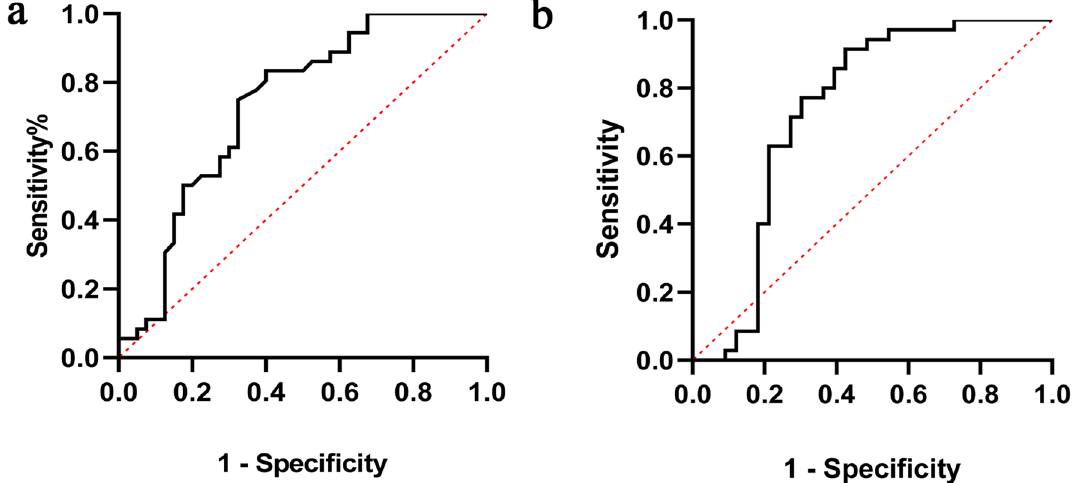
Figure 2. ROC curve analysis for determining statistically significant differences between study groups. ( a ) ROC curve of Sporadic patients and healthy controls analyzed for relative expression level of VDR (AUC: 0.73, p value: 0.0005). ( b ) ROC curve of Sporadic patients and HFR group analyzed for relative expression level of CRB3 (AUC: 0.73, p value: